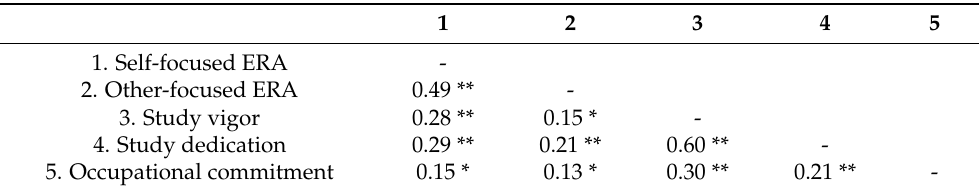
Table 2. Descriptive statistics and correlations among study variables.